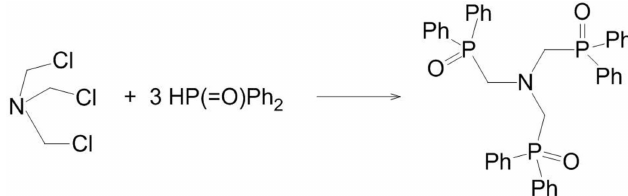
Figure 3 The preparation of the title compound.